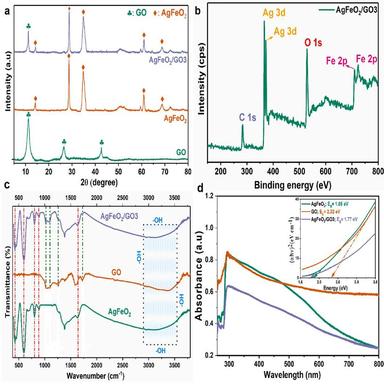
(a) XRD results of AgFeO2, GO, and AgFeO2/GO3 catalysts. (b) XPS survey of AgFeO2/GO3 catalyst. (c) FTIR spectra of AgFeO2, GO, and AgFeO2/GO3 catalysts. (d) UV–Vis absorbance spectra of AgFeO2, GO, and AgFeO2/GO3 with direct bandgap calculation using Tauc plot as inset.